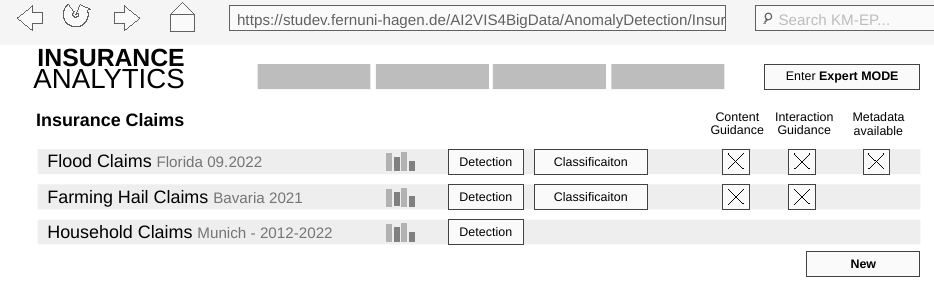
Figure 10. Data-centric wireframe for the cost accountant end user view.